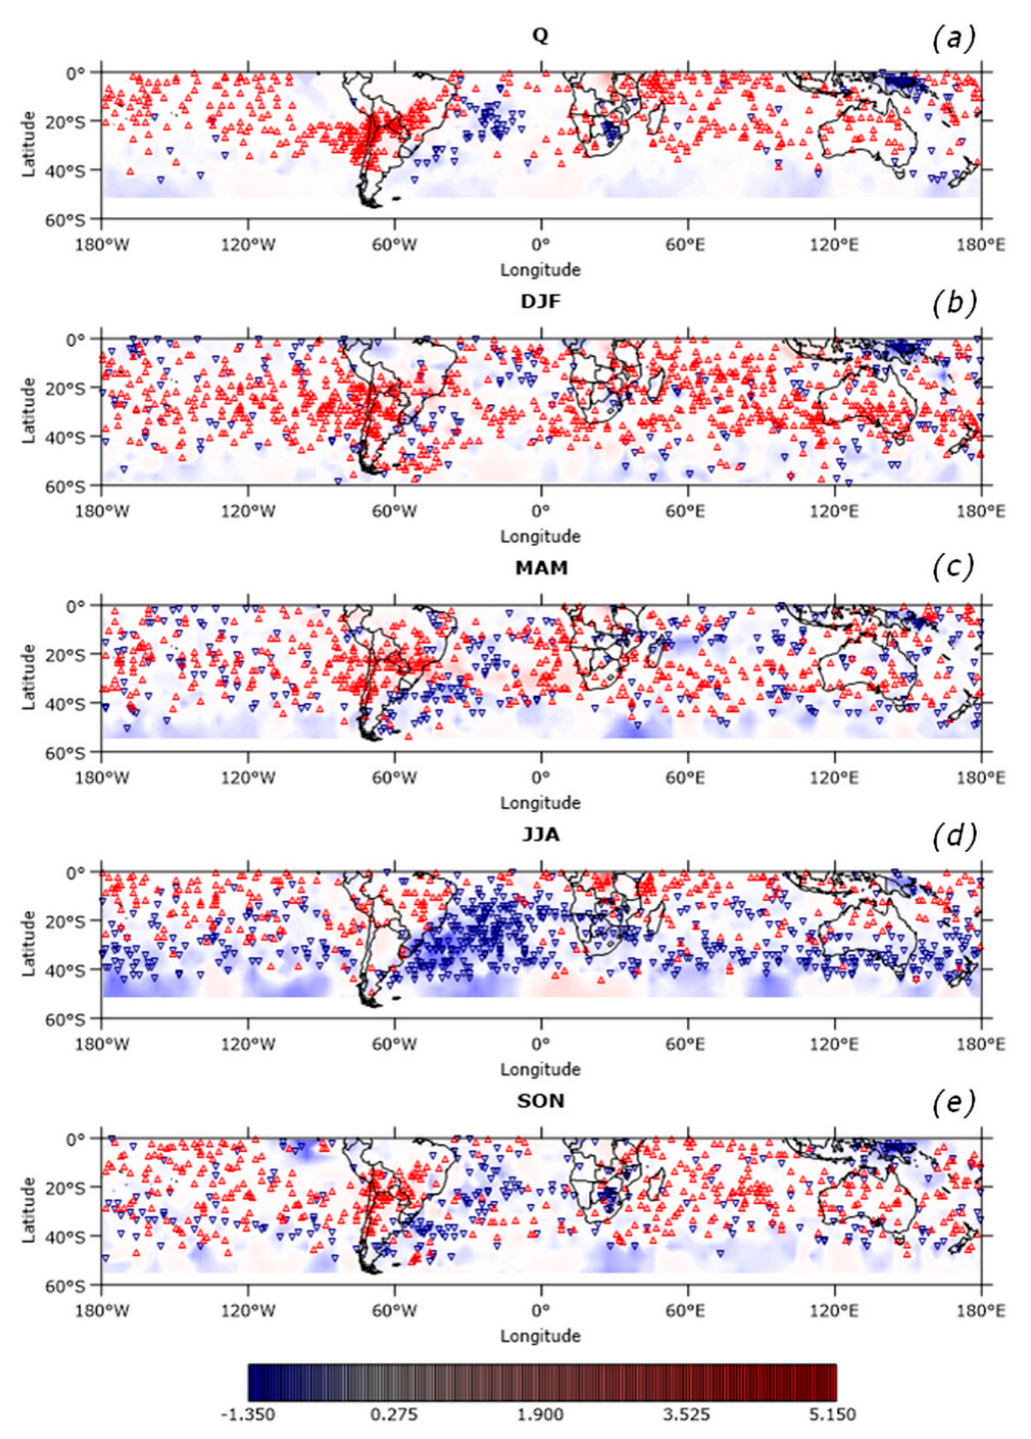
Figure 5. As in Figure 3 but for the SO 2 seasonal concentrations in the upper troposphere and the lower stratosphere (STL). Q, DJF, MAM, JJA and SON figures are shown in panels ( a – e ),